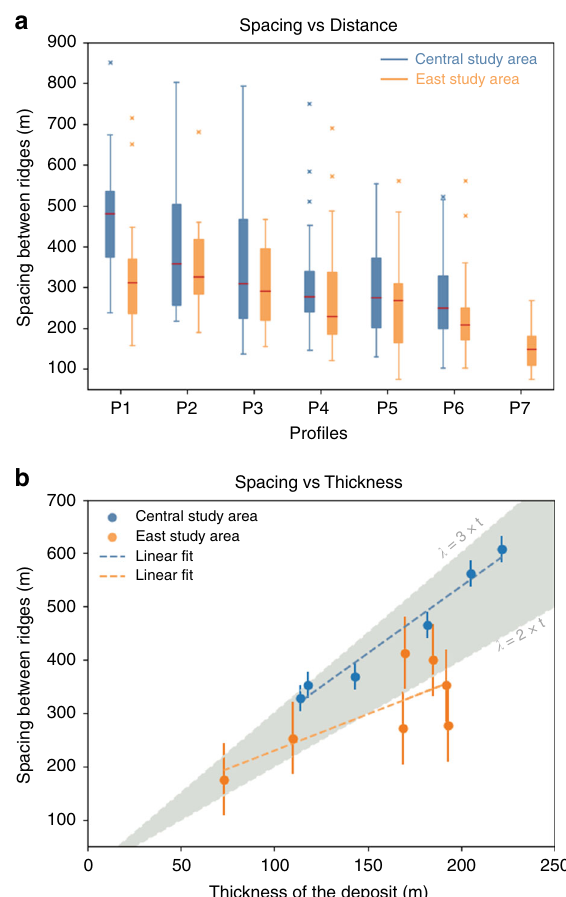
Fig. 2 Variation of the spacing between longitudinal ridges with the distance and with the thickness of the deposit. Panel a shows how the spacing between longitudinal ridges varies with distance (from the proximal to distal areas of the deposit); boxes represent the ‘ interquartile range ’ , red segments within boxes show the median value, whiskers above and below boxes show the locations of the maximum and minimum, symbols ‘ x ’ represent values above three times the interquartile range. Panel b shows the relationship between the spacing of the ridges and the thickness of the deposit; the grey band shows the experimentally predicted range for the scaling relationship between the spacing between the ridges and